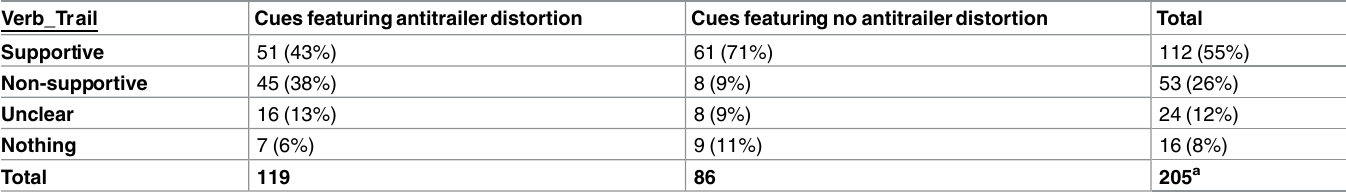
Table 4. Separate-scales group: frequency and proportionof codesassignedto verbalizations aboutthe trailingdiagnosis (Verb_Trail). Verb_Trail